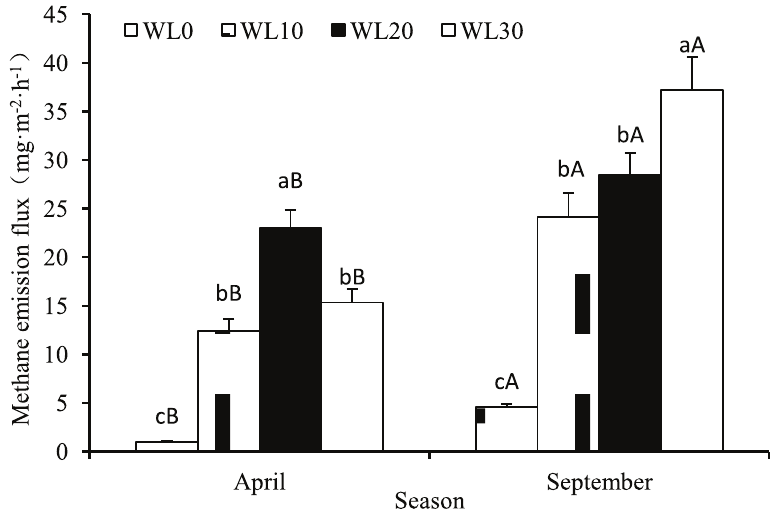
gradient under inundated conditions in September. At each water level, the SOC was generally higher in the 0–5 cm surface layer than that in other layers. With respect to the pH at various water levels, in April, the pH was lowest at WL30 and highest at WL0. In September, the oppo- site results were obtained. The electrical conductivity of soil in April and September was gener- ally higher at WL0 than at other water levels. The soil Eh varied greatly with water level, but the relationship between Eh and depth was not consistent at different water levels. Comparing the SOC at different water levels, for a given soil layer, the SOC was higher at WL0 and WL30 than at WL10 or WL20. The pH and SOC were higher in September than in April, and Eh was lower in September than in April. There was no apparent seasonal difference in the electrical conductivity of soil.